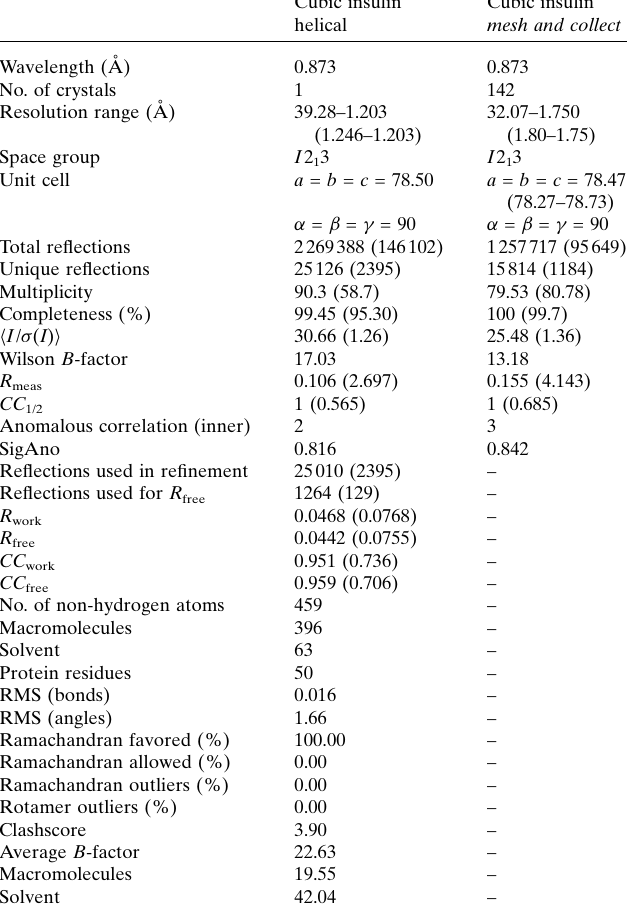
Table 2 Data collection and refinement statistics. Statistics for the highest-resolution shell are shown in parentheses. For the mesh and collect data, the average cell edge and range are provided. A refinement was not performed for these data.